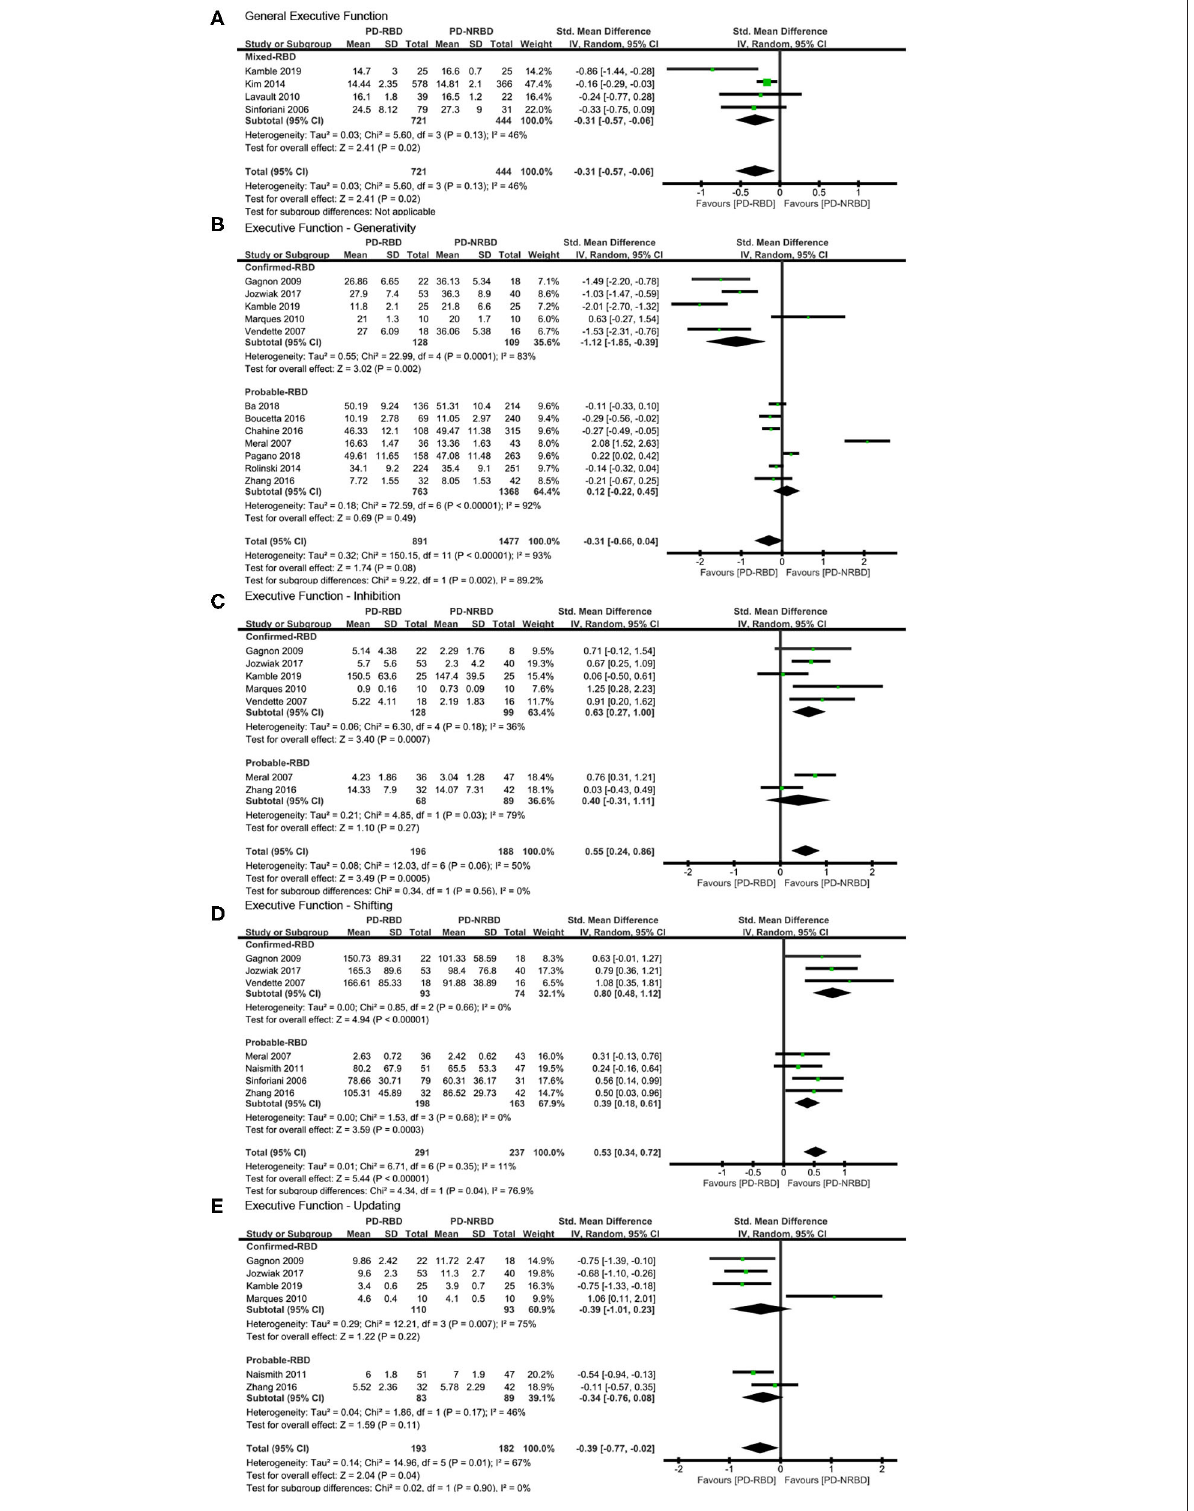
FIGURE 4 | Forest plot for (A) general executive function (EF), (B) generativity with subtotals by the diagnosis of rapid eye movement sleep behavior disorder (RBD), (C) inhibition with subtotals by the diagnosis of RBD, (D) shifting with subtotals by the diagnosis of RBD, and (E) updating with subtotals by the diagnosis of RBD displaying effect size calculated using a random-effects model. SD , standard deviation; Std. Mean Difference , standardized mean difference; CI , confidence interval.